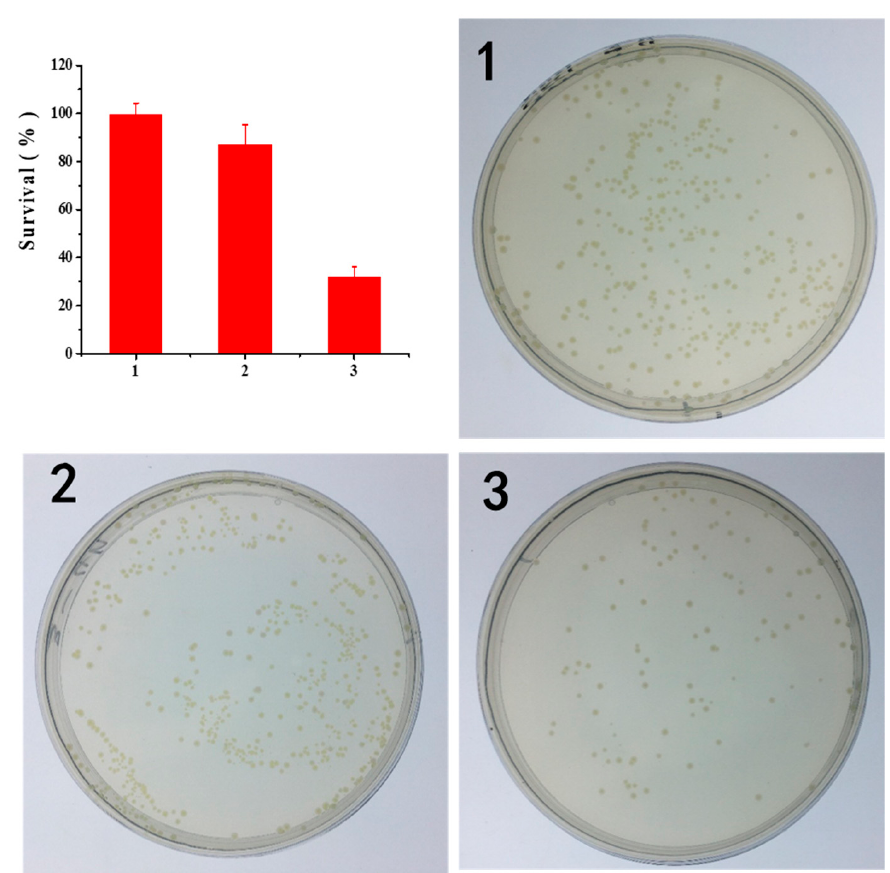
Figure 6. Bactericidal properties of the ( 1 ) black, ( 2 ) TiO 2 mesoporous material, and ( 3 ) TiO 2 + CNT mesoporous composite. mesoporous